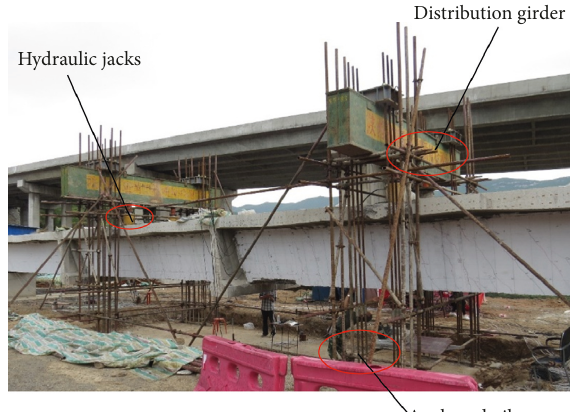
Figure 8: Loading device.